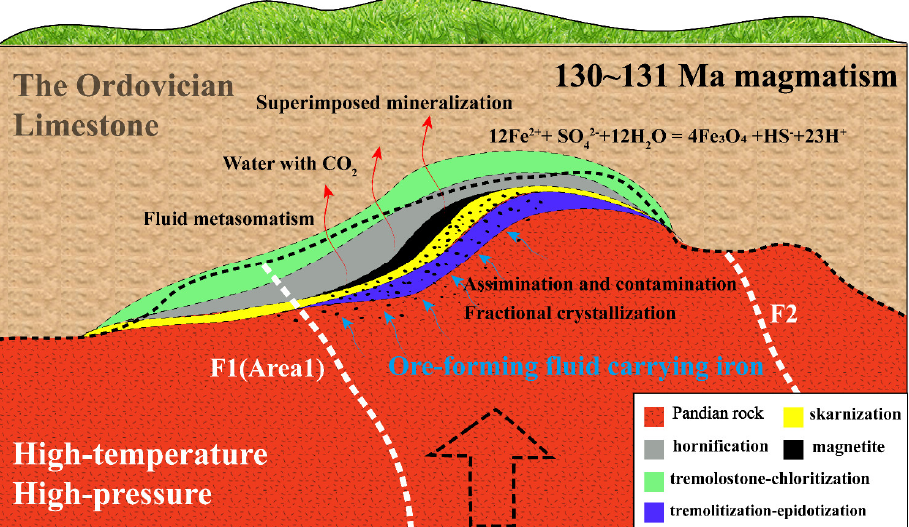
Figure 10. Schematic diagram of magnetite mineralization in Pandian. Black dashed arrow shape indicates upwelling of magma heat sources. Black dashed line represents the boundary of the Pandian rock we inferred. The red arrows show water with CO 2 , and the blue arrows indicate the direction of ore-forming fluid carrying iron. F1 (Area 1) and F2 represent the lithologic alteration/fracture belts (zones) we deduced.